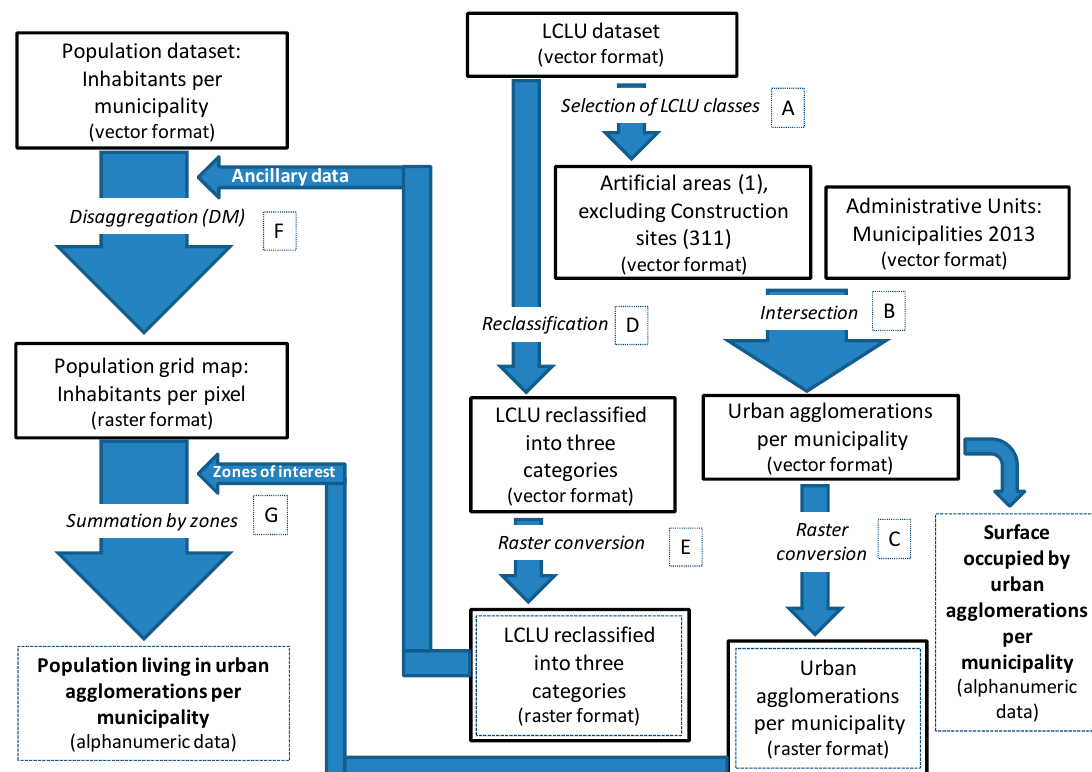
Figure 1. Workflow used to assess the surface occupied by urban agglomerations and the corresponding population, per municipality.